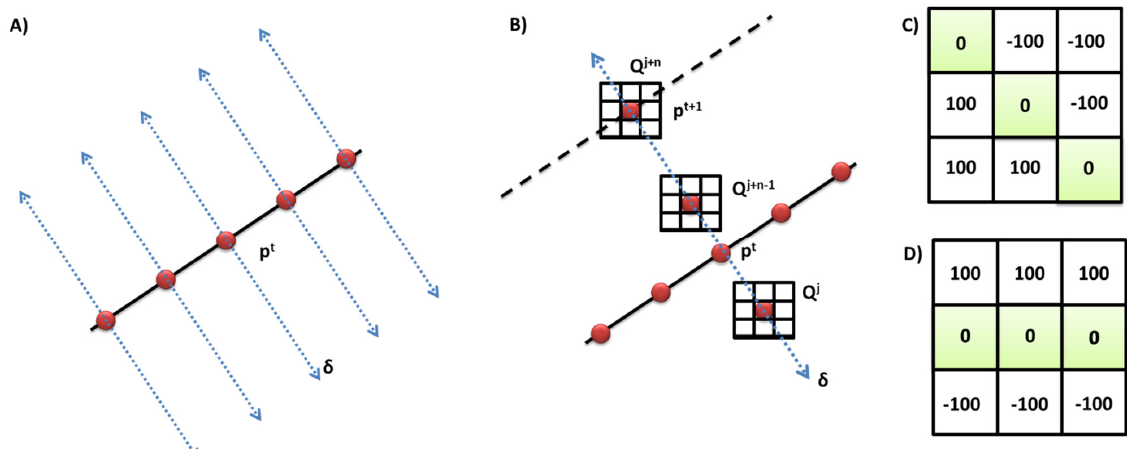
Figure 3. Determining the point position in the next image using the oriented gradient algorithm: A) calculating the normal at sample points, B) Sampling along the normal, C)-D) 2 out of the 180 3x3 predetermined masks, C) 180 o , D) 45 o (Comport et al., 2003). ViSP’s overall workflow is shown in Figure 1. The pose estimation process begins by forward projecting the 3D model onto the current image frame using the previous frame’s camera pose. The Moving Edges (ME) algorithm (Boutemy,